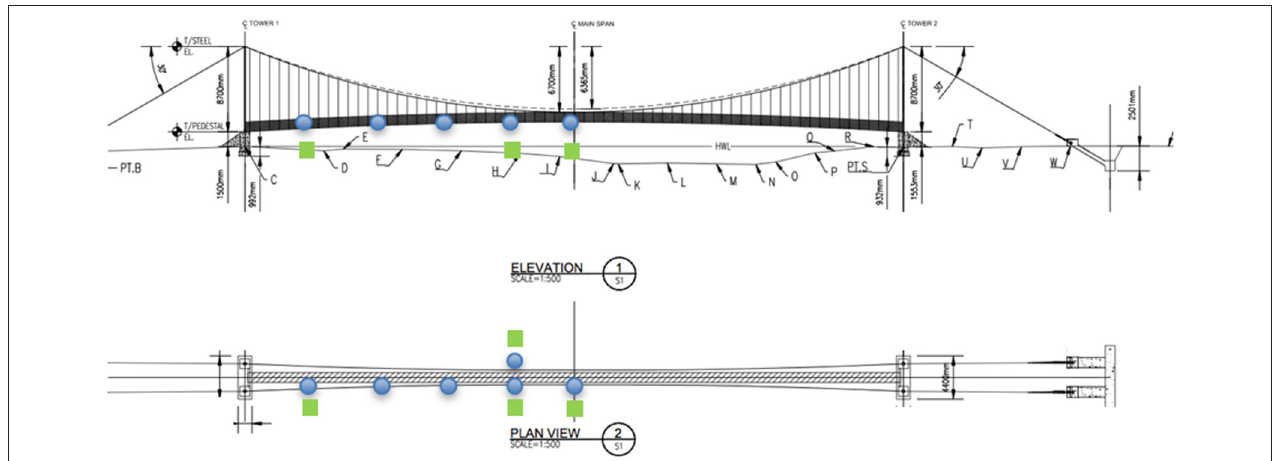
FIGURE 5 | Sensor placements of the Microstrain system (circles) and Vibration Sentries (squares) at Rancheria footbridge in Nicaragua.